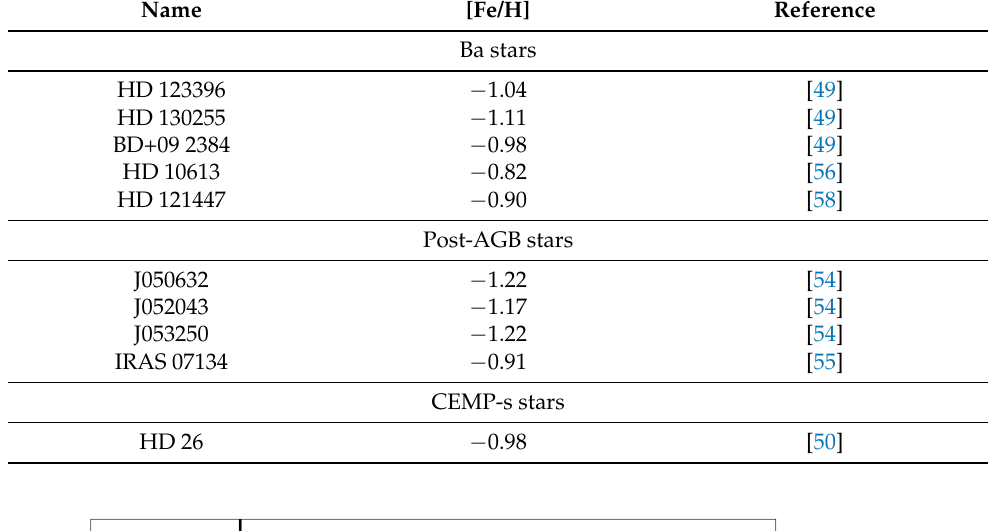
Table 4. Overview of the observational sample: names, references, and [Fe/H] are given for each star.